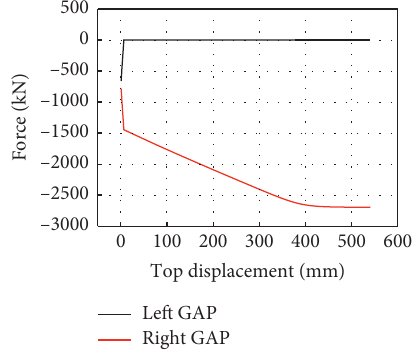
Figure 12: Force versus deformation of GAP.